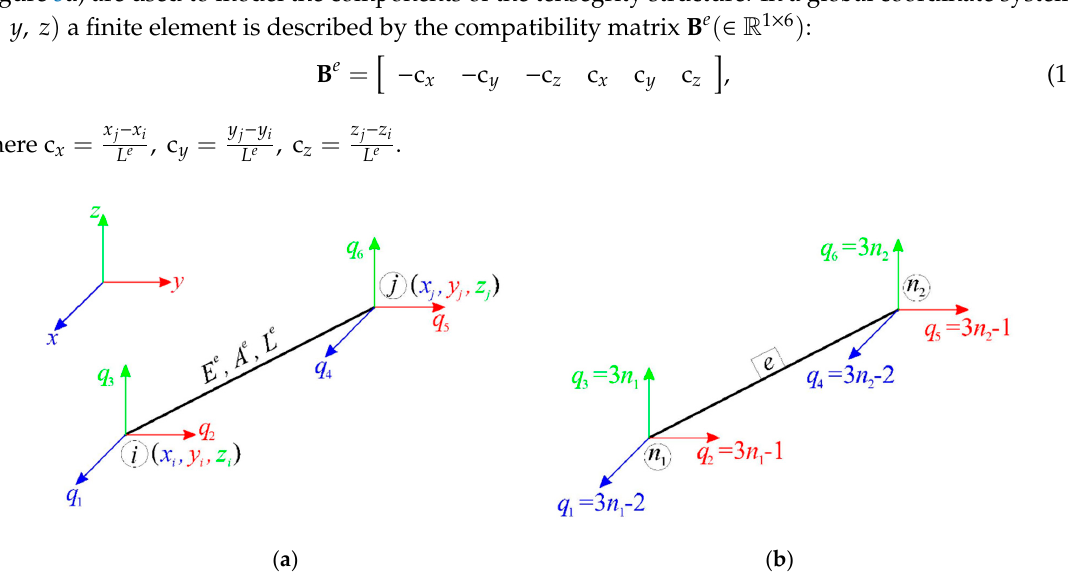
Figure 4. Practical applications of tensegrity in civil engineering: ( a ) Blur Building [46], ( b ) a patio roof of a bank annex (Athens, Greece) [47], ( c ) an exhibition pavilion for Patras Cultural Capital of Europe (Patras, Greece) [47].